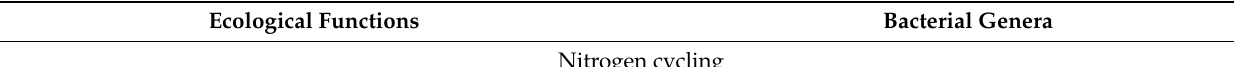
Table 1. Putative ecological functions inferred for bacterial genera commonly present in the Cladophora microbiomes collected from CKD, PUA, and